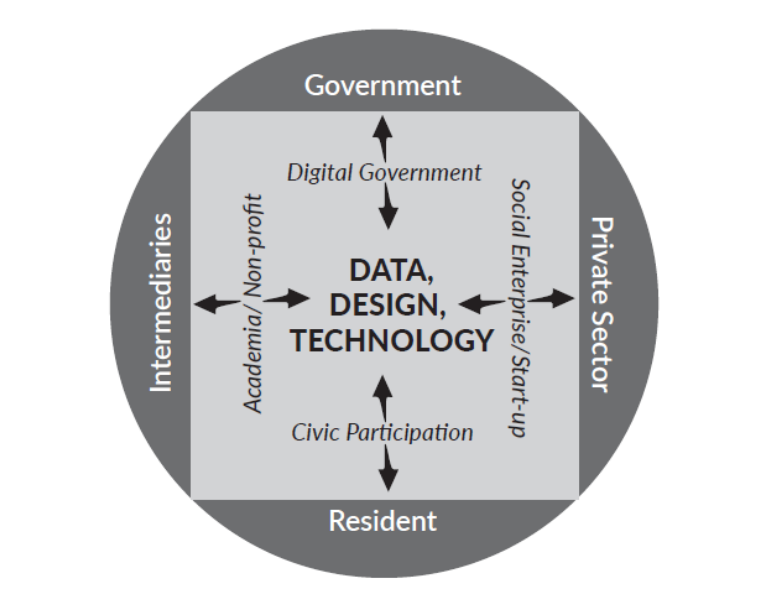
Figure 1: Civic tech ecosystem. Source: